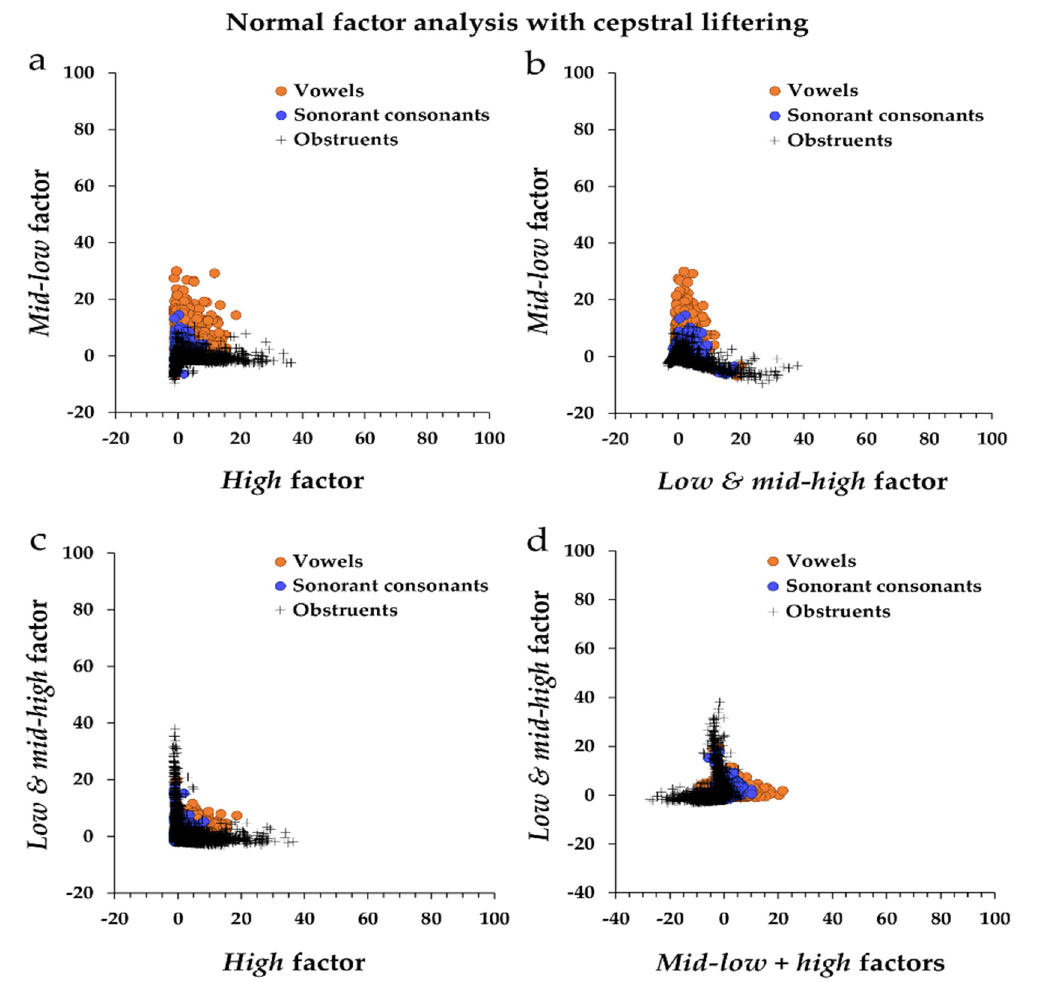
Figure 3. The distribution of factor scores by normal factor analysis with cepstral liftering. ( a – c ) represent all possible combinations of two factors out of the three factors, and ( d ) shows a two-dimensional mapping of the three factors.